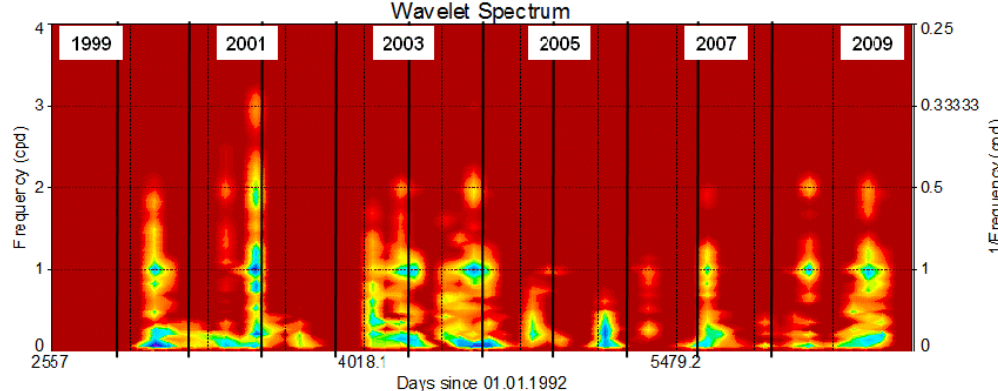
Fig. 12. Continuous Wavelet spectrum of 15-min data during 11 years (1999–2009, annual divisions are shown). Data gaps are filled by Figure 12: Continuous Wavelet spectrum of 15-minutes data during 11 years (1999 – 2009, annual divisions are shown). Data gaps are filled by linear interpolation. The wavelet model used is Morlet linear interpolation. The wavelet model used is Morlet with adjustable parameter=20. with adjustable parameter = 20.